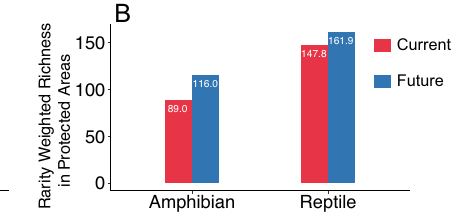
Fig. 1 | Percent of species that have suitable habitats in protected areas (PAs). A Percentofspeciesrichness B therarityweightedrichnessinPAsatpresentandby 2070(RCP4.5).SeeSupplementaryFig.2fortheRCPs2.6,6.0,8.5;Supplementary Figs. 3 and 4 for small range and threatened species; see Supplementary Figs. 5 – 7